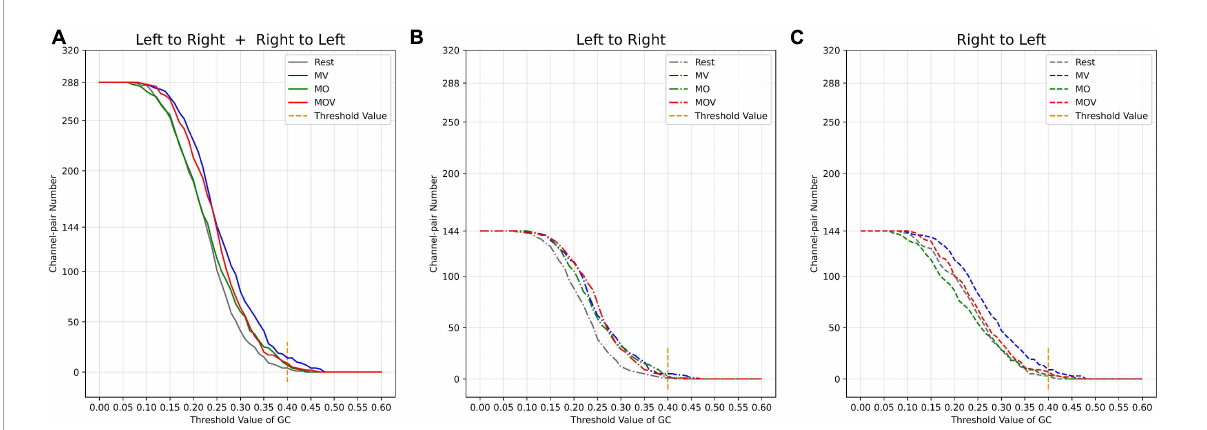
FIGURE9 Relationship between threshold selection and the number of channel pairs. (A) The number of causal connections from the left- to the right brain and from the right- to the left brain by different GC thresholds. (B) The number of causal connections from the left- to right brain by different GC thresholds; (C) the number of causal connections from the right- to the left brain by different GC thresholds.